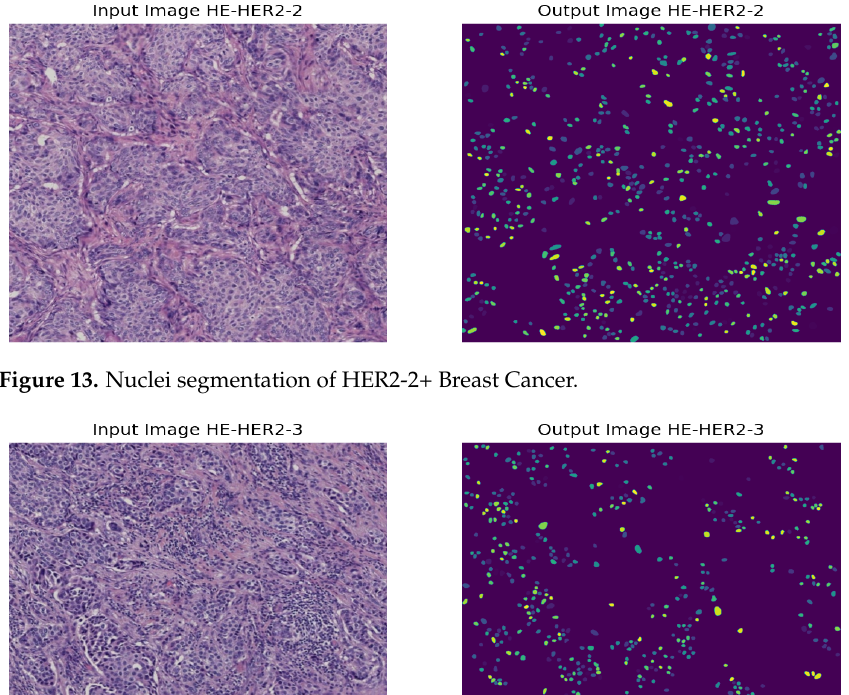
Figure 12. Nuclei segmentation of HER2-1+ Breast Cancer.